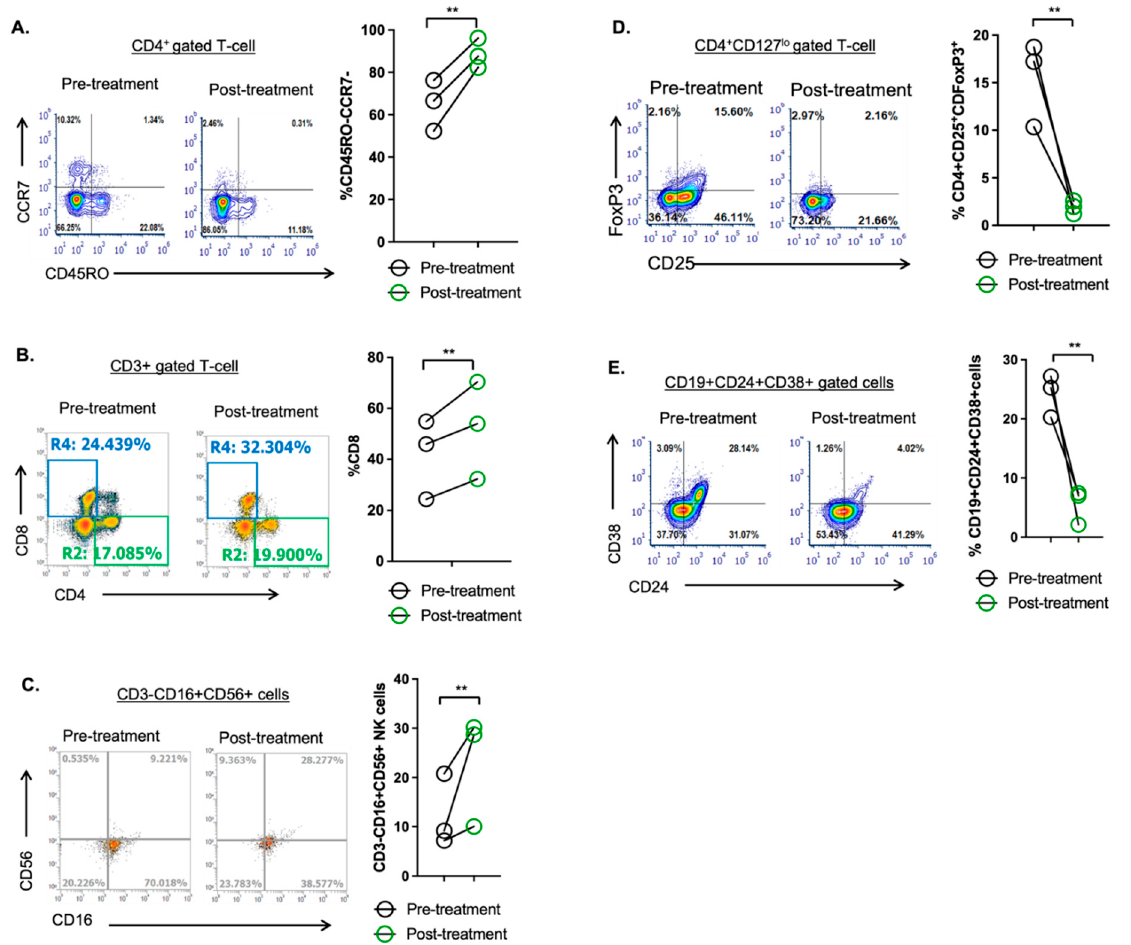
Figure 5. ARd therapy promotes anti-tumor immune reconstitution in MM patients. Flow cytometry was performed on bone marrow mononuclear cells isolated from MM patients who achieved >PR. Relative to pre-treatment, ( A ) CD4+ Th effector cells, ( B ) CD8+ cytotoxic T-cells and ( C ) NK cells were significantly increased in post-treatment samples whereas pro-tumor ( D ) T-regulatory and E.